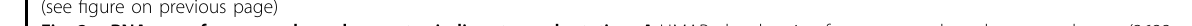
Fig. 2 scRNA-seq of mononuclear phagocytes in liver transplantation. A UMAP plot showing four mononuclear phagocyte clusters (3622 cells) in liver transplantation, colored according to different clusters (left panel). Dendrogram of four clusters by the hierarchical clustering analysis based on their normalized mean expression values (right panel). B Violin plots showing the normalized expression of CD14 , S100A8 , C1QC , and CD68 genes ( y - axis) for TMo and KC clusters ( x -axis). C Heatmap of top ten differentially expressed genes between different mononuclear phagocyte clusters. The line is colored according to clusters in Fig. 2A. D Gene Ontology enrichment analysis results of mononuclear phagocyte clusters. Only the top 20 most signi fi cant GO terms ( p value < 0.05) are shown in rows. E Cell ratio of different mononuclear phagocyte clusters in PP, EP, and PR samples. F Number of upregulated DEGs between different timepoint samples in different mononuclear phagocyte clusters. G Gene Ontology enrichment analysis results of upregulated DEGs in C1QC_KC cluster after reperfusion (PR vs. EP). Only the top 20 signi fi cant GO terms ( p value < 0.05) are shown in rows. H The gene set variation analysis (GSVA) showing the pathways (PID and BIOCARTA gene sets) with signi fi cantly different activation in different samples of mononuclear phagocyte clusters. Different colors represent different activation